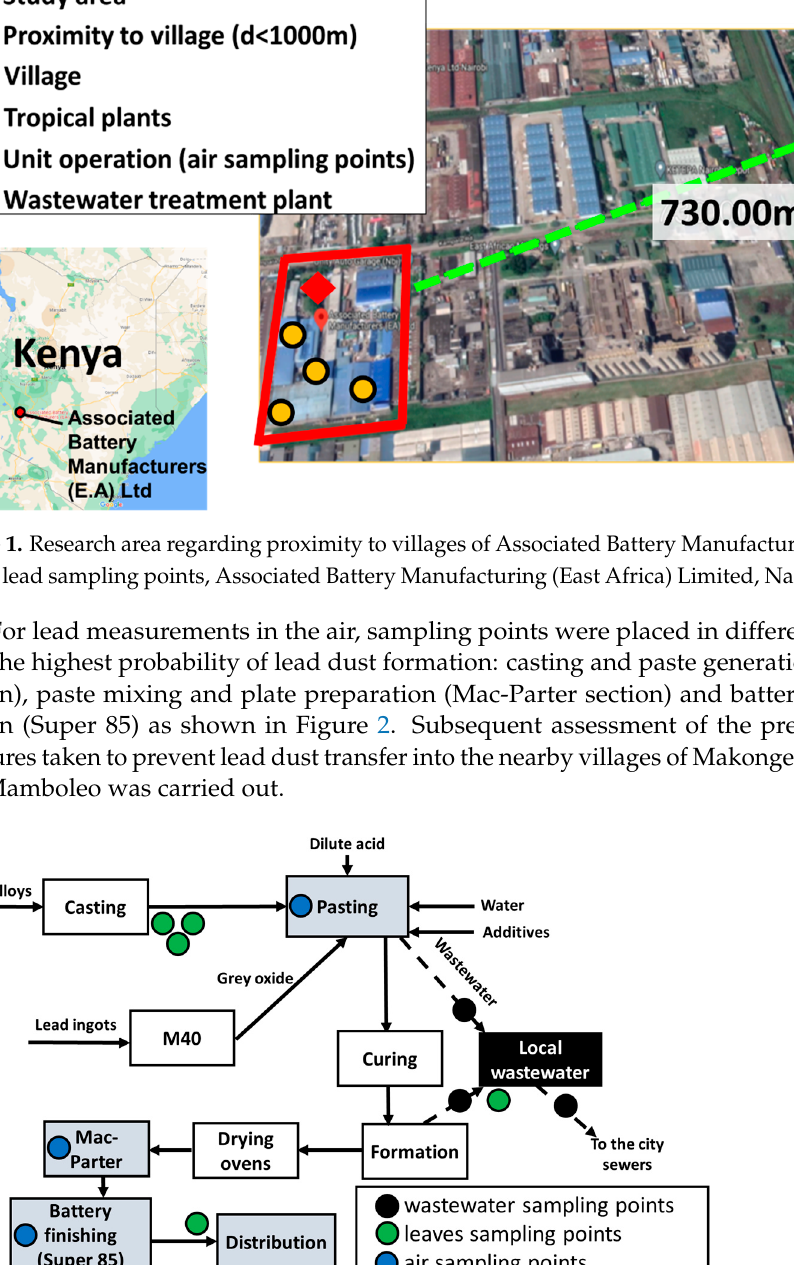
Figure 2. Schematic mapping of battery production stages and unit operations with marked points for air sampling, leaf sampling and wastewater quality measurements.